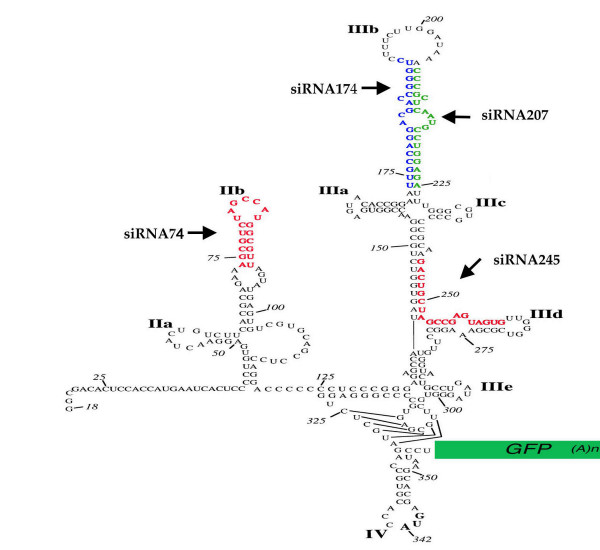
Location of siRNA targets to the 5'UTR of HCV genome. Predicted secondary structure of the 5' UTR sequences (18–357). The sequence shown is that of the genotype 1a 5'UTR, HCV-H [40], and the structure based on previous studies [41-43]. Stem-loop structures are labeled for reference. The chimeric clones were made by fusing the GFP-encoding sequence, including a poly (A) tail, after the CCU sequence of the 5'UTR by overlapping PCR. The locations of siRNA targets in the stem-loop regions are shown by arrows.